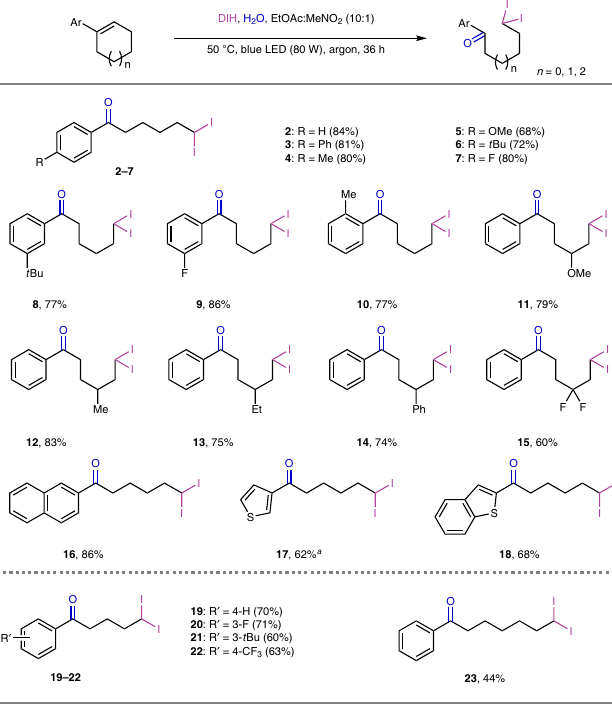
Fig. 2 Scope of oxidative deconstructive geminal diiodination of cyclic alkenes. Isolated yields unless otherwise indicated. Performed with alkene (0.2 mmol), H 2 O (10 mmol), DIH (0.4 mmol) in EtOAc:MeNO 2 (10:1), irradiated under blue LED lamps (80 W) for 36 h at 50 °C. a 4 equiv NIS instead of DIH.